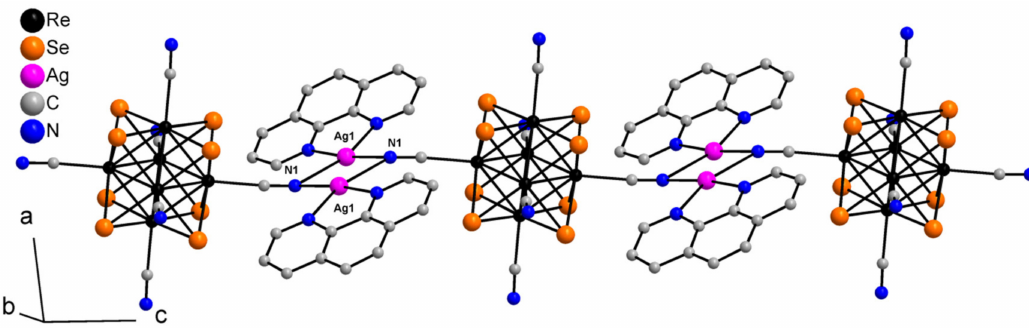
Figure 4. Fragment of compound 1 .